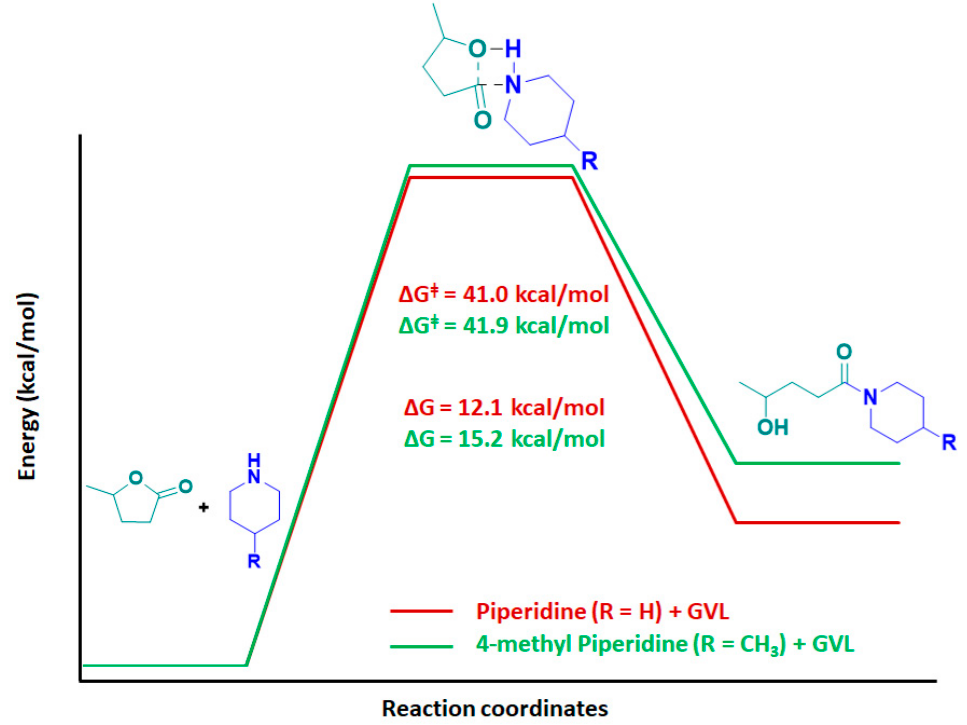
Figure 8. Reaction pathway to explain GVL ring opening in the presence of PIP and 4-MP.